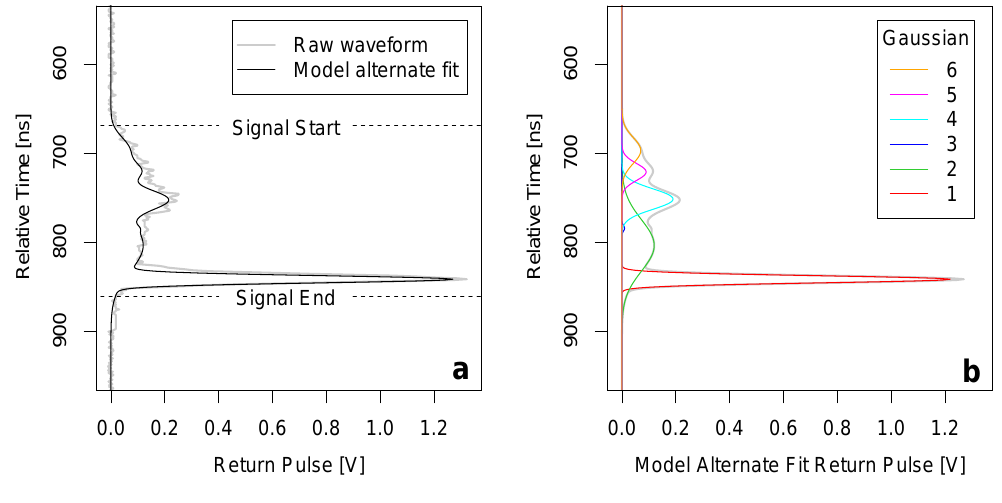
Figure 1. ( a ) Example of the Geoscience Laser Altimeter System (GLAS) waveform for a vegetated surface, with approximate signal start and end locations and the model alternate fit waveform calculated from the sum of up to six Gaussians; ( b ) decomposition of the waveform by six Gaussians.